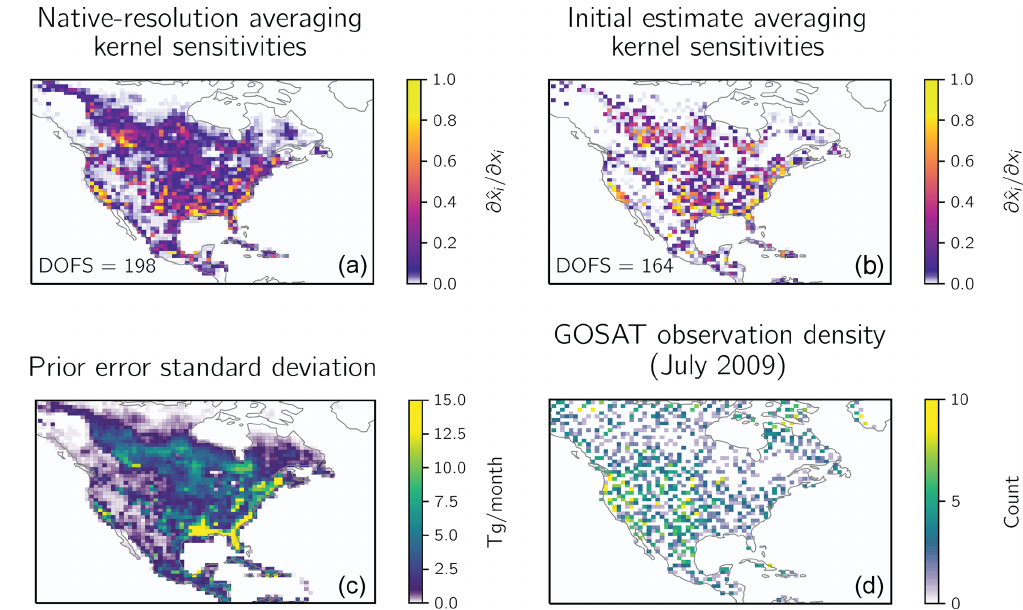
Figure 2. Averaging kernel sensitivities for the demonstration inversion of GOSAT observations with enhanced information content for July 2009. The top panels show the sensitivities given by the diagonal elements of the averaging kernel matrix A of the native-resolution inversion (a) and of the initial estimate of the averaging kernel matrix A ( 0 ) (b) . The DOFS for each averaging kernel matrix are inset in the corresponding panel. Panel (c) shows the error standard deviations on the prior emissions estimate given by the square roots of the diagonal elements of S A . Panel (d) shows the GOSAT observation density.